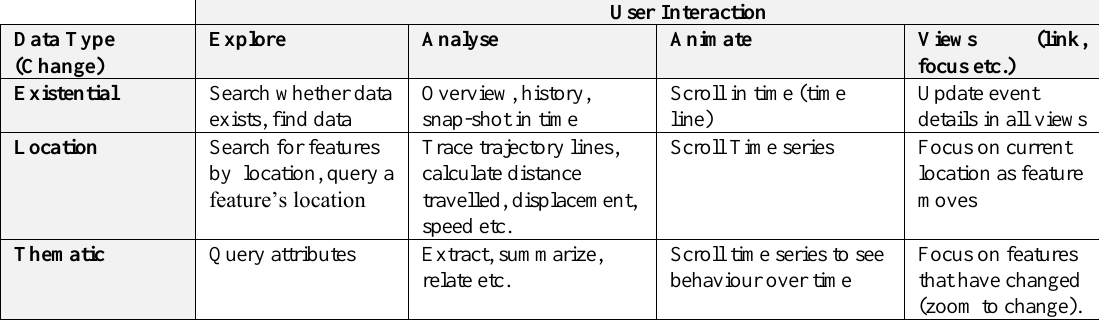
Table 2. Example of relationship between data type and the type of interactions and analysis that